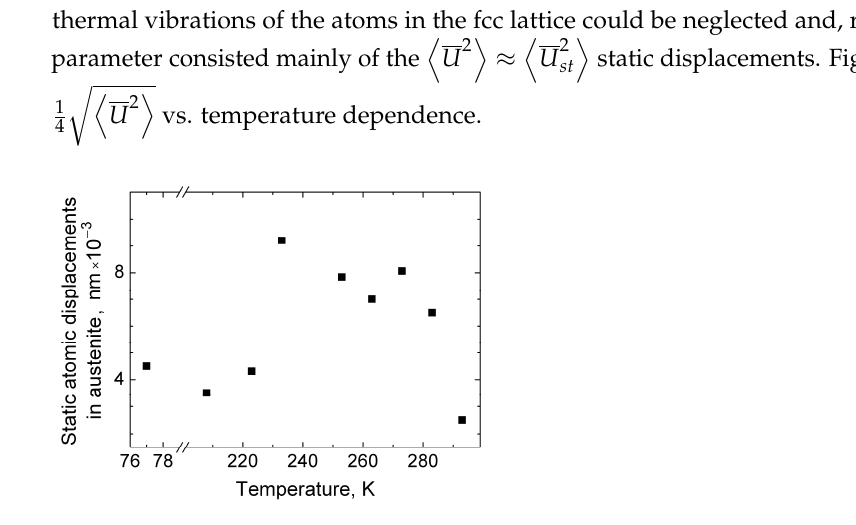
Figure 6. The RMS atom displacements vs. temperature dependence for the fcc lattice of the Cr-Mn-N steel after the tensile tests.